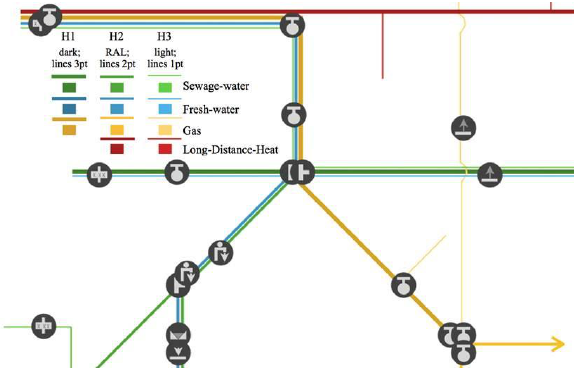
Figure 9. representation of infrastructure following the metro map concept and the proposed symbolization The aggregates further indicate the location of multiple lines and additionally underline the importance of objects for decision-making. Failures in those confined spaces might affect other objects in the near surrounding and the information about these is essential for crisis response and the estimation of potential consequences.